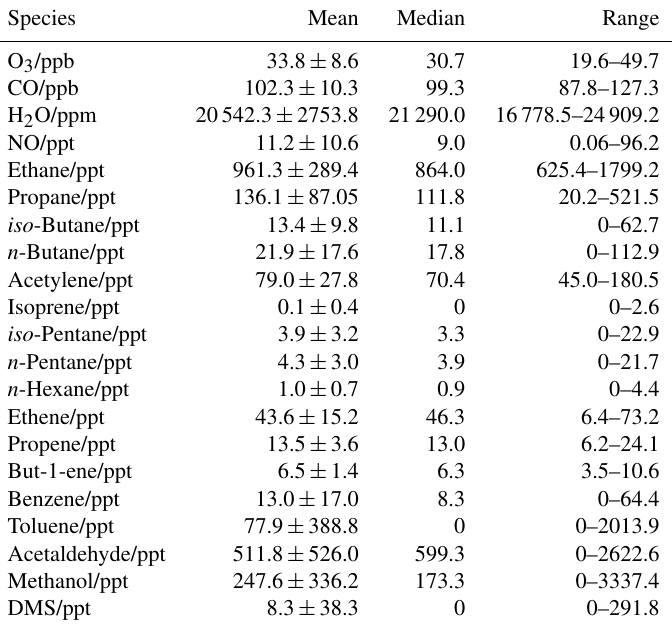
Table 1. Summary of inputs to the model. Zero values indicate measurements below the limit of detection. Further details can be found in Vaughan et al. (2012) and Carpenter et al.